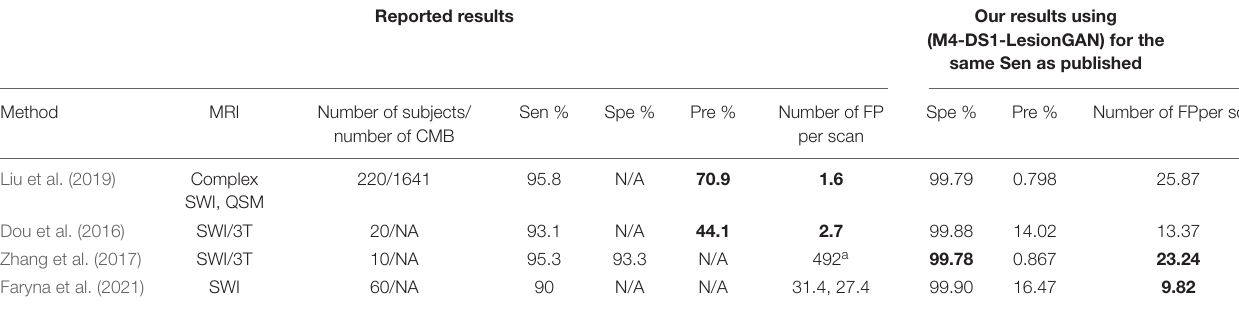
TABLE 4 | State-of-the-art performance for cerebral microbleed (CMB) classification. Reported results Our results using